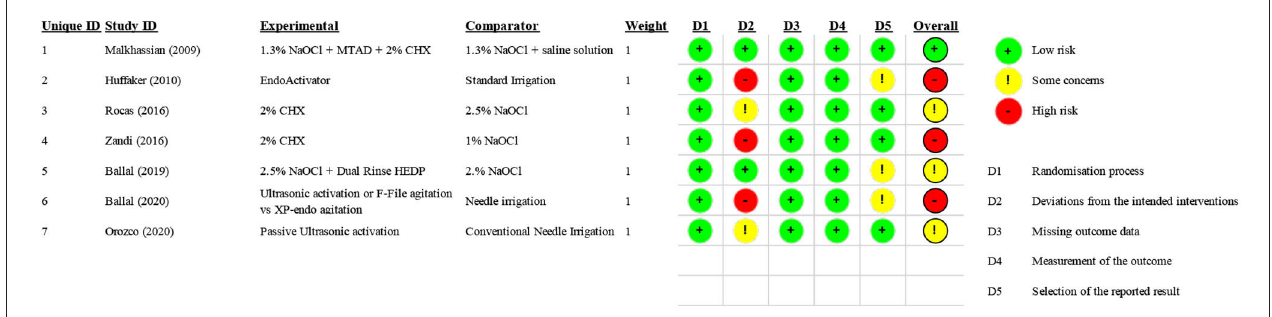
FIGURE 2 | Risk of Bias—ROB2.